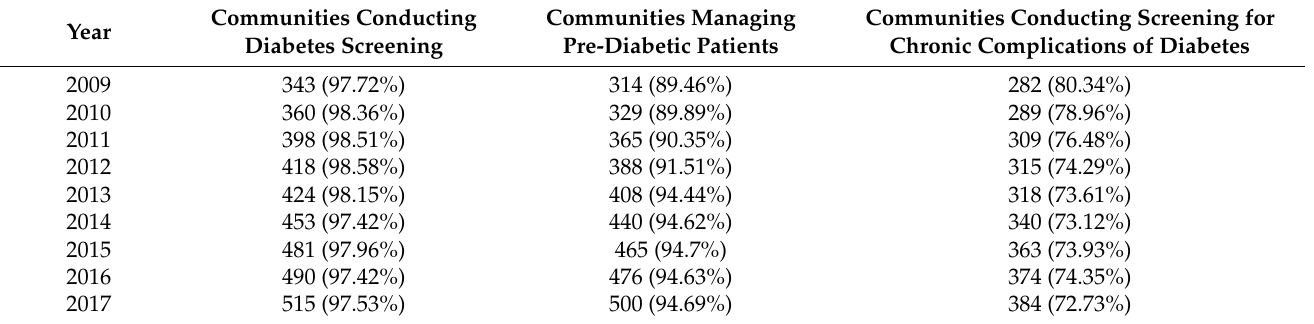
Table 3. Numbers and proportions of communities provided with early-stage management of diabetes from 2009 to 2017. Communities Conducting Communities Managing Year Diabetes Screening Pre-Diabetic